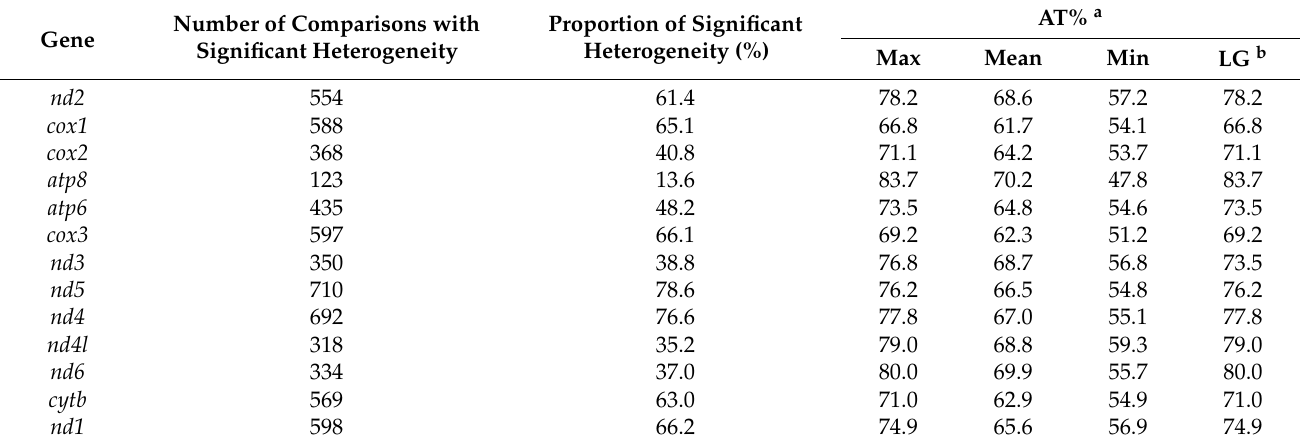
Table 3. I D test summary and AT% on individual mitochondrial